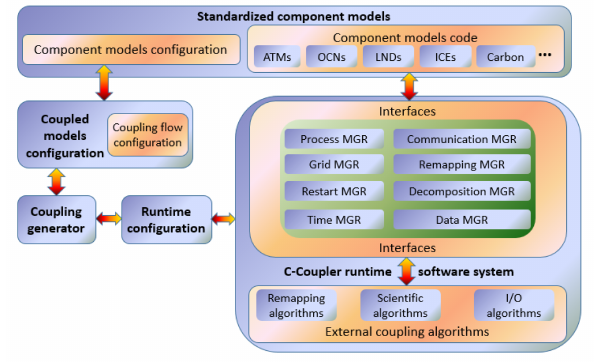
Figure 1. Original software design of C-Coupler (from Liu et al., 2014).